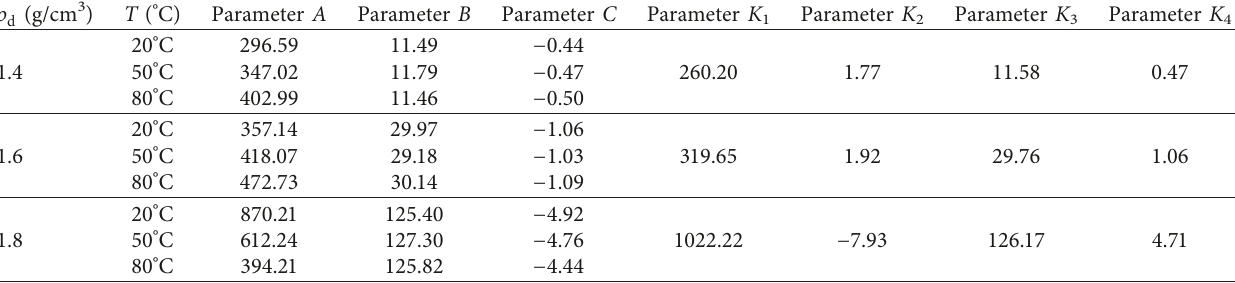
Figure 8: The relationship of cohesion, water content, and temperature under the dry density of 1.4g/cm 3 . (a) The relationship between water content and cohesion. (b) The relationship between parameter A and temperature. Table 5: The parameters’ value under different dry densities and temperatures.